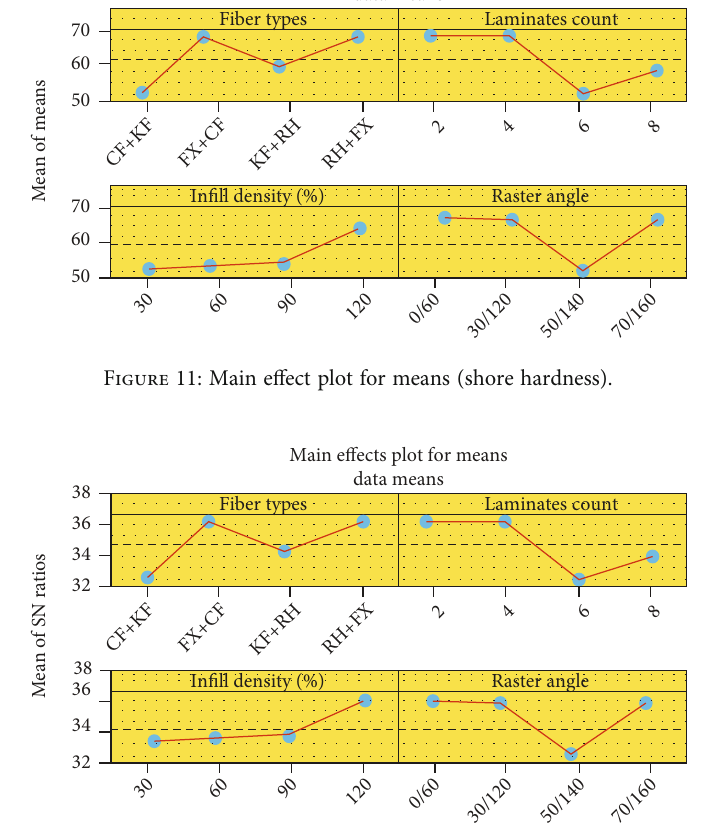
Figure 12: Main e ff ect plot for S/N ratio (shore